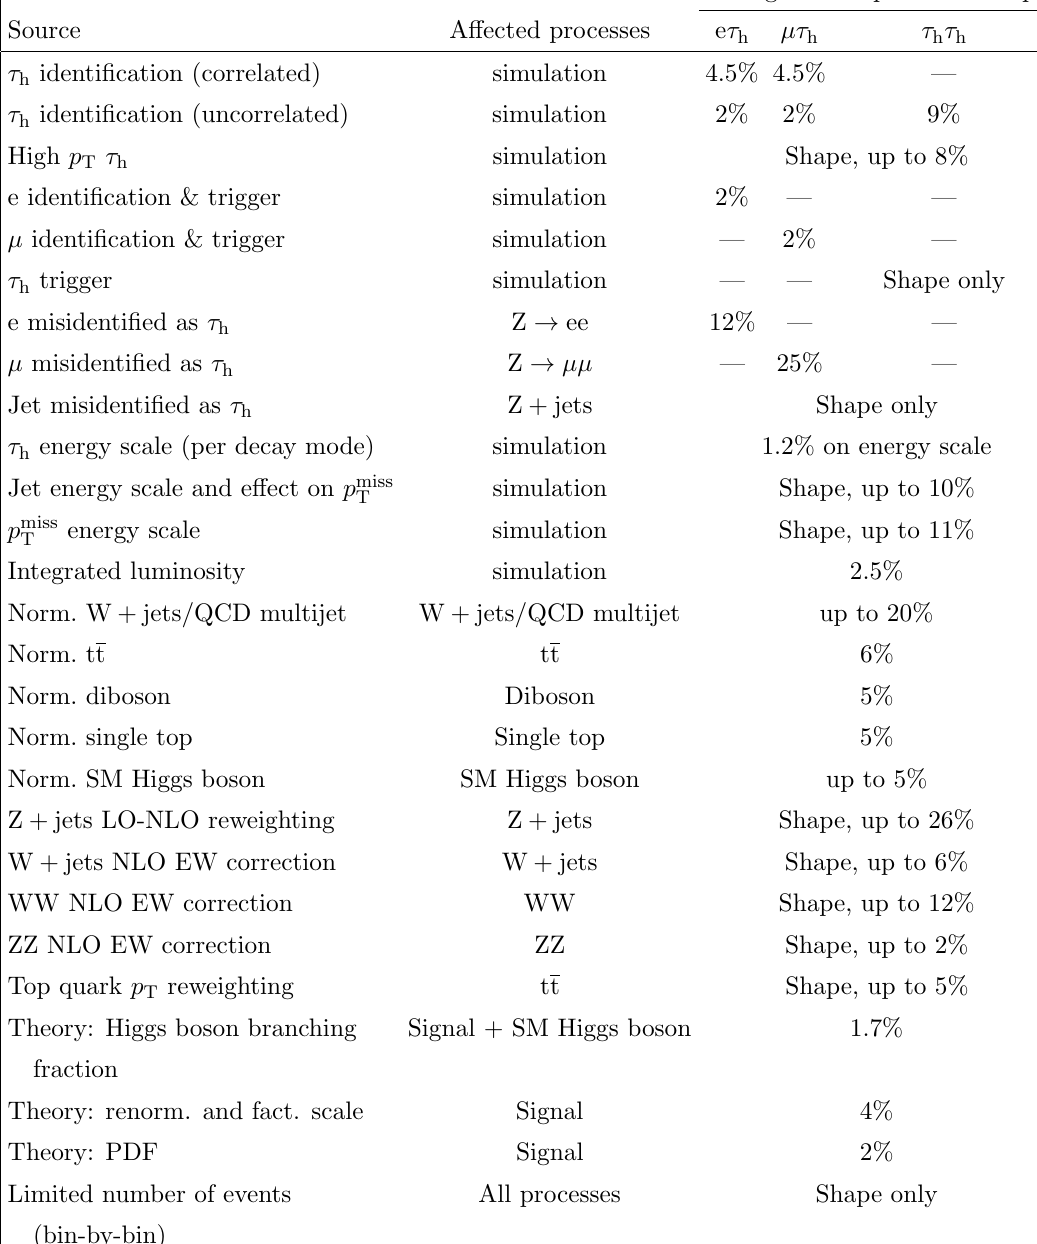
Table 4 . Systematic uncertainties a(cid:11)ecting signal and background in the h ! (cid:28) + (cid:28)